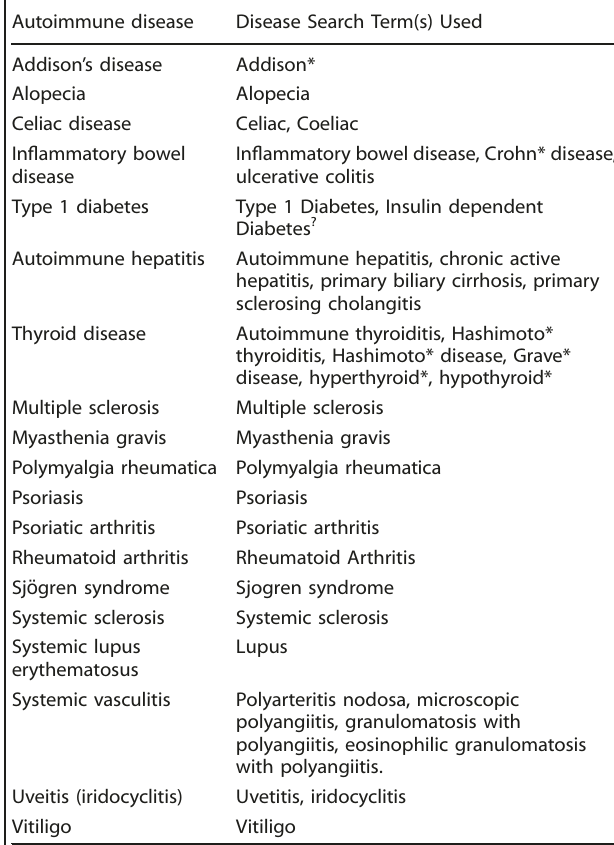
Table 2. Search terms used in OvidSP and EBSCO for each autoimmune